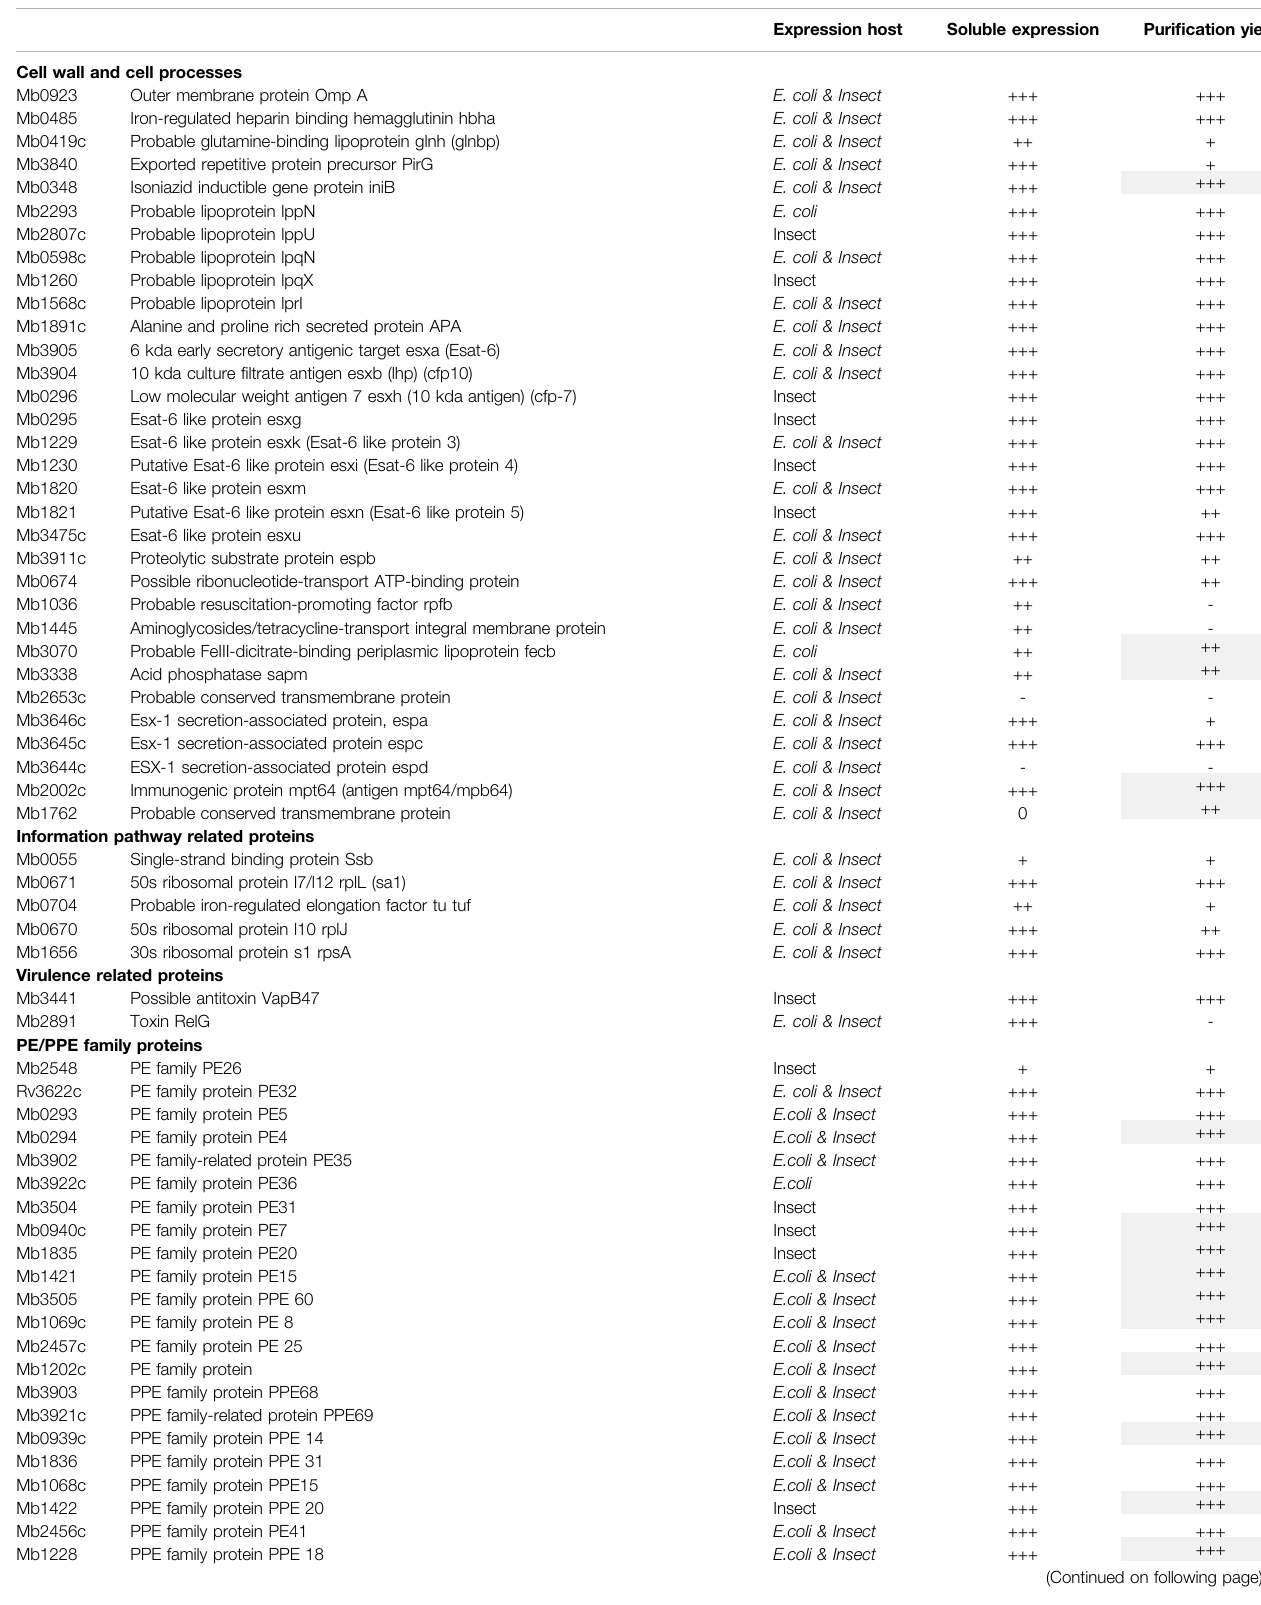
Expression host Soluble expression Puri fi cation